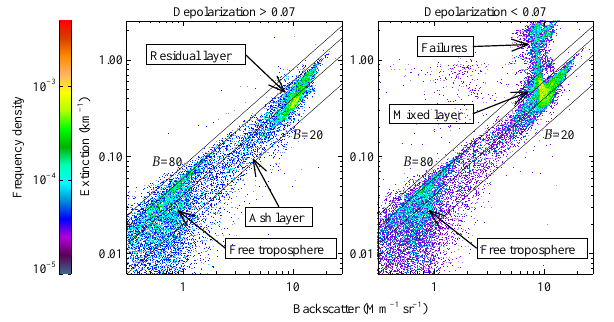
Fig. 19. Distribution of extinction and backscatter for 19 April 2010. Lines delineate lidar ratios of 20, 40, 60, and 80 sr . Left – Points observed to have a volume depolarization ratio > 0 : 07 , which likely contain some quantity of ash. Right – The remaining points, corresponding to typical PBL aerosols and failed retrievals near the surface.